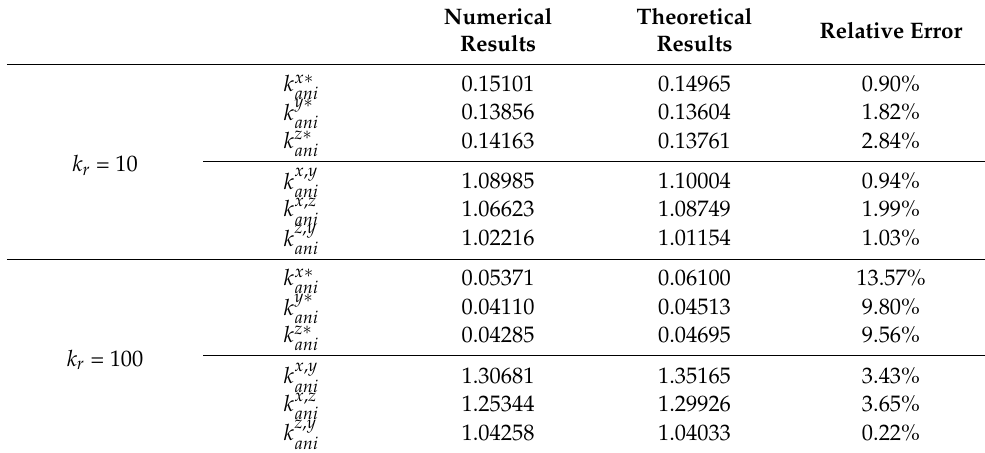
Table 4. The ETCs in different direction at ε =